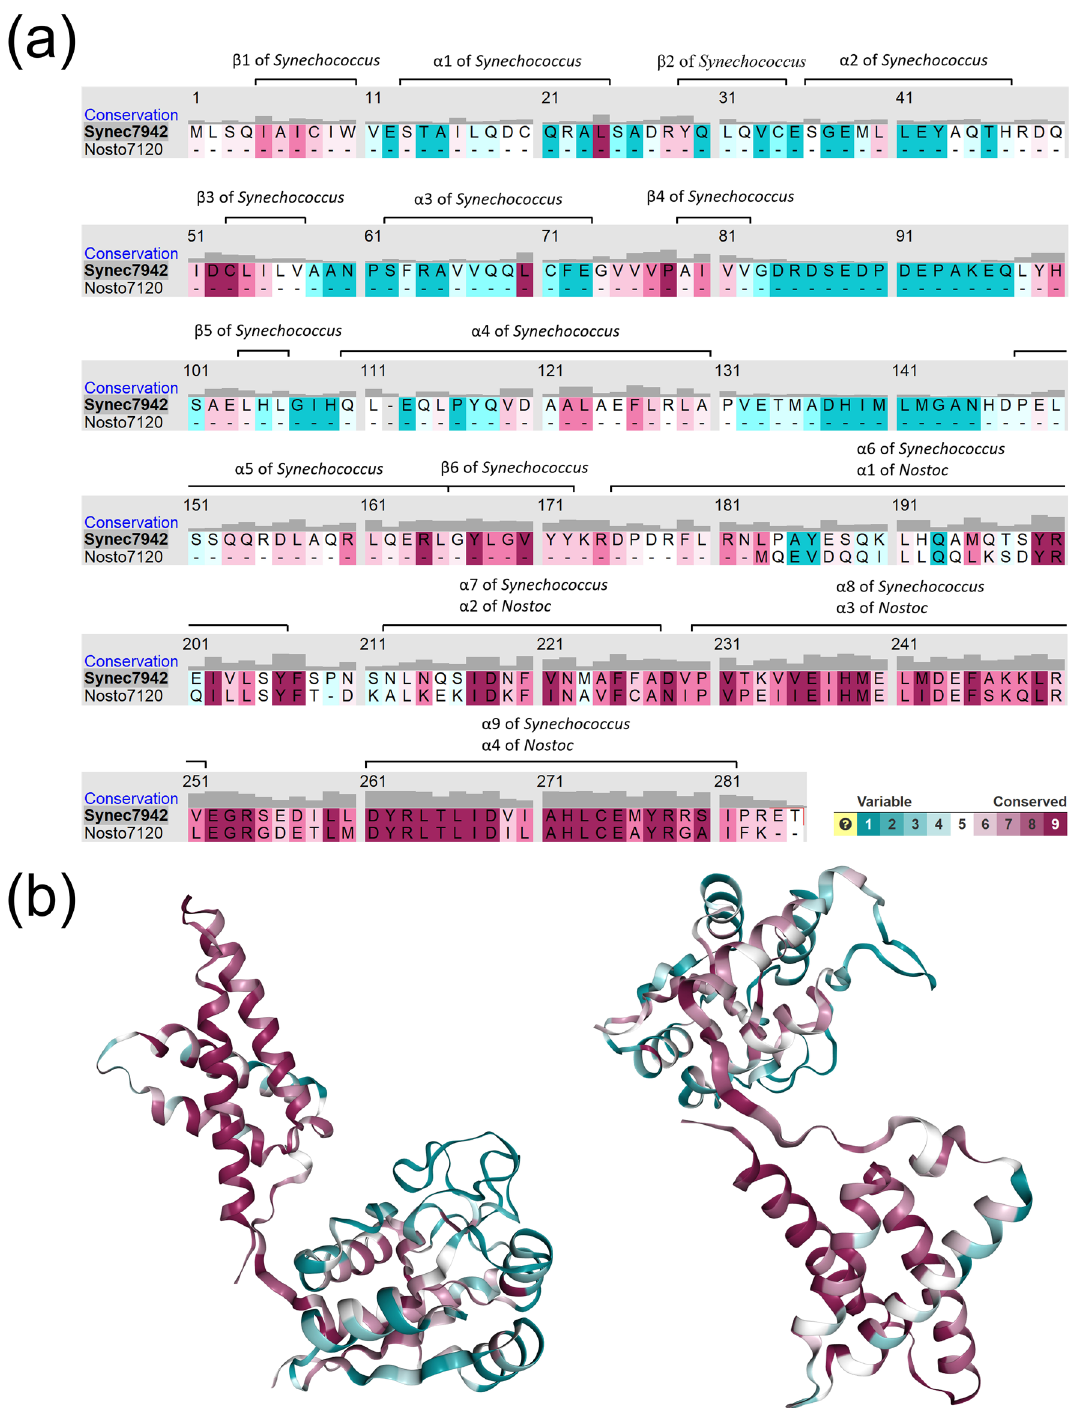
Figure 2. Group-conserved residues identified by ConSurf. Degrees of conservation in subfamilies were visualized by Chimera v.1.10.2 17 . ( a ) Conserved sites of the KaiA protein. Number the residues is accordant with the Synechococcus KaiA (ABB57248). The black bars above sequence indicate the level of conservation (1–9). ( b ) Conserved sites labeled (red) in the 3D structure of the Synechococcus elongatus KaiA protein (PDB: 1R8J_A) (left: N-terminal region; right: KaiA